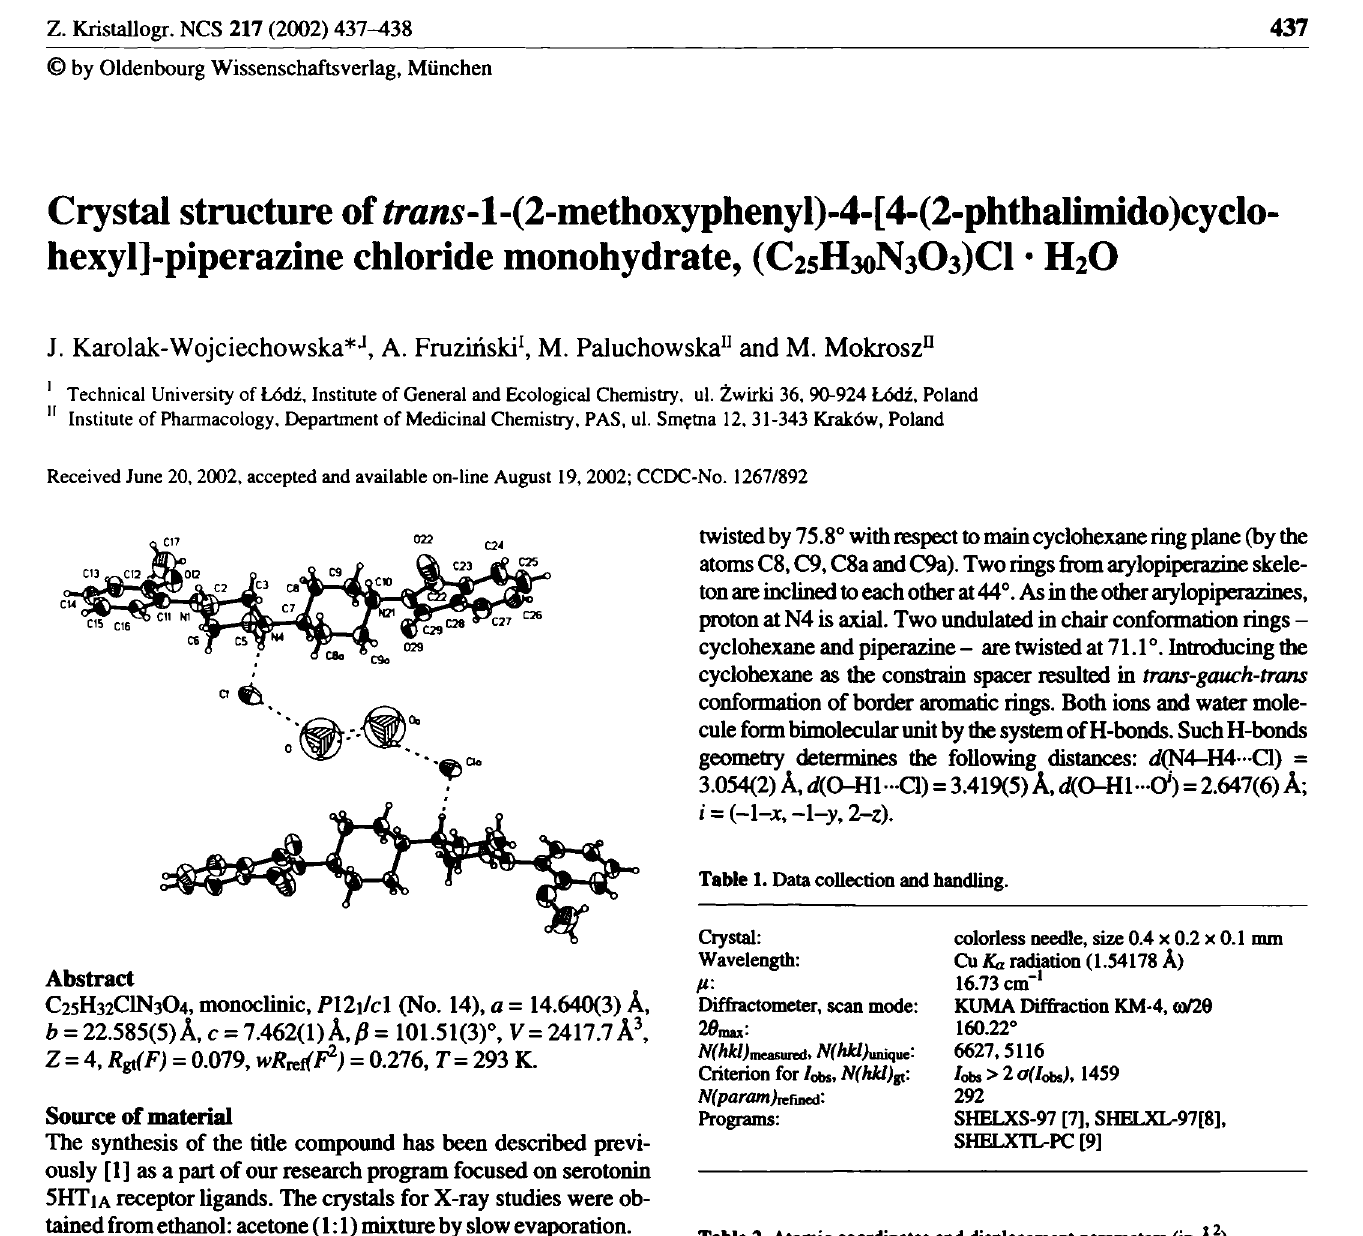
Table 2. Atomic coordinates and displacement parameters (in Â 2